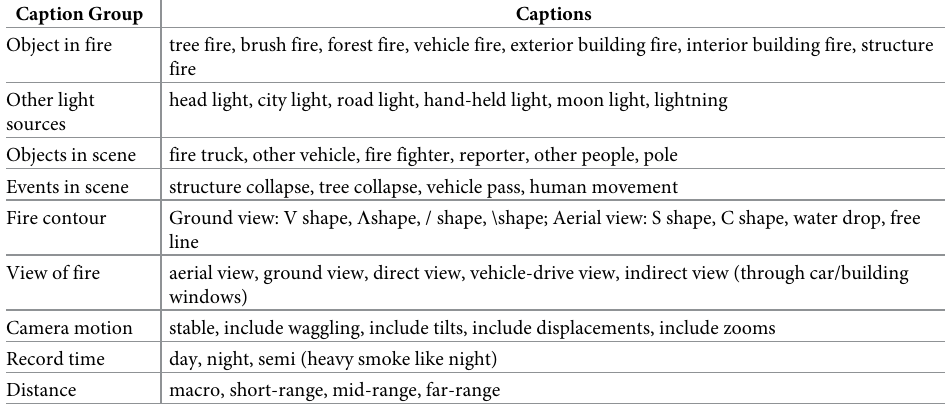
Table 1. Video tags used for the